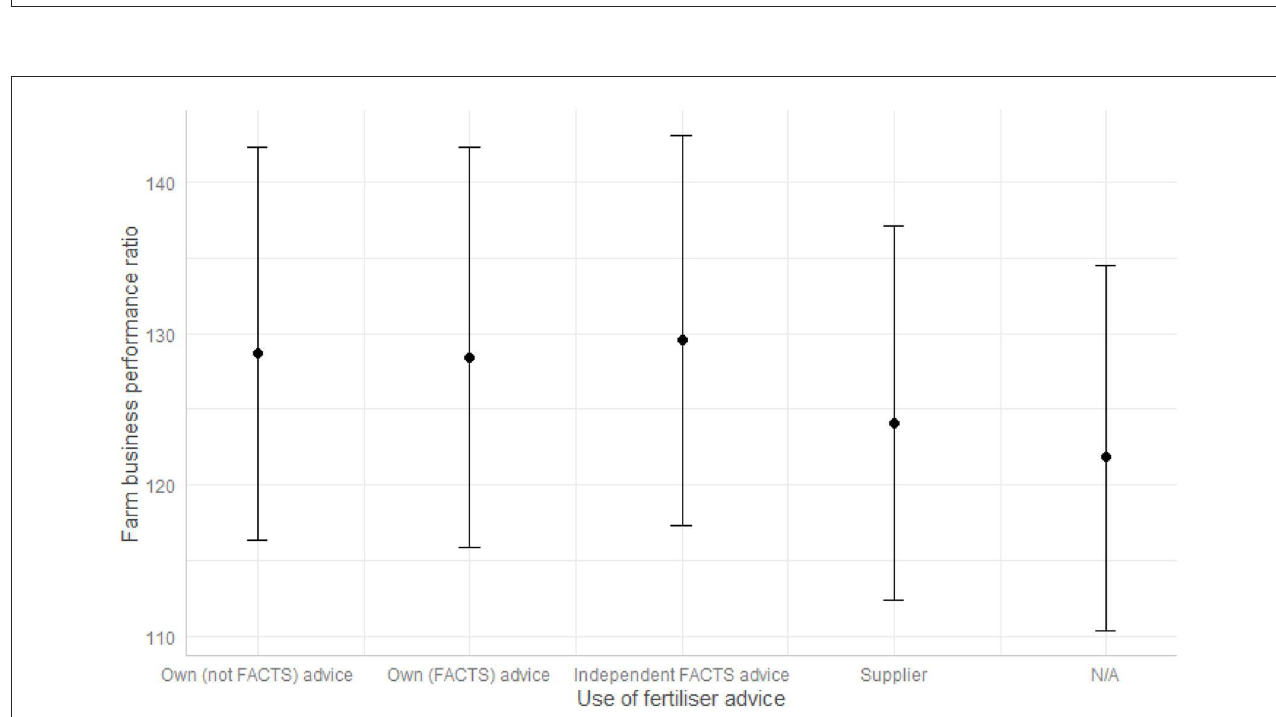
FIGURE7 Mean and 95% confidence intervals of marginal predicted values of farm business performance ratio (back-transformed from log farm business performance ratio) generated from the final model, by fertilizer